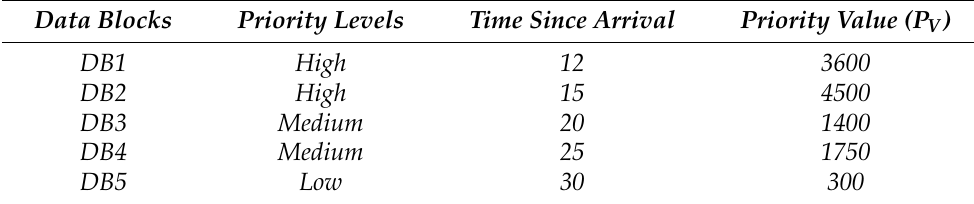
Table 2. Priority values of data